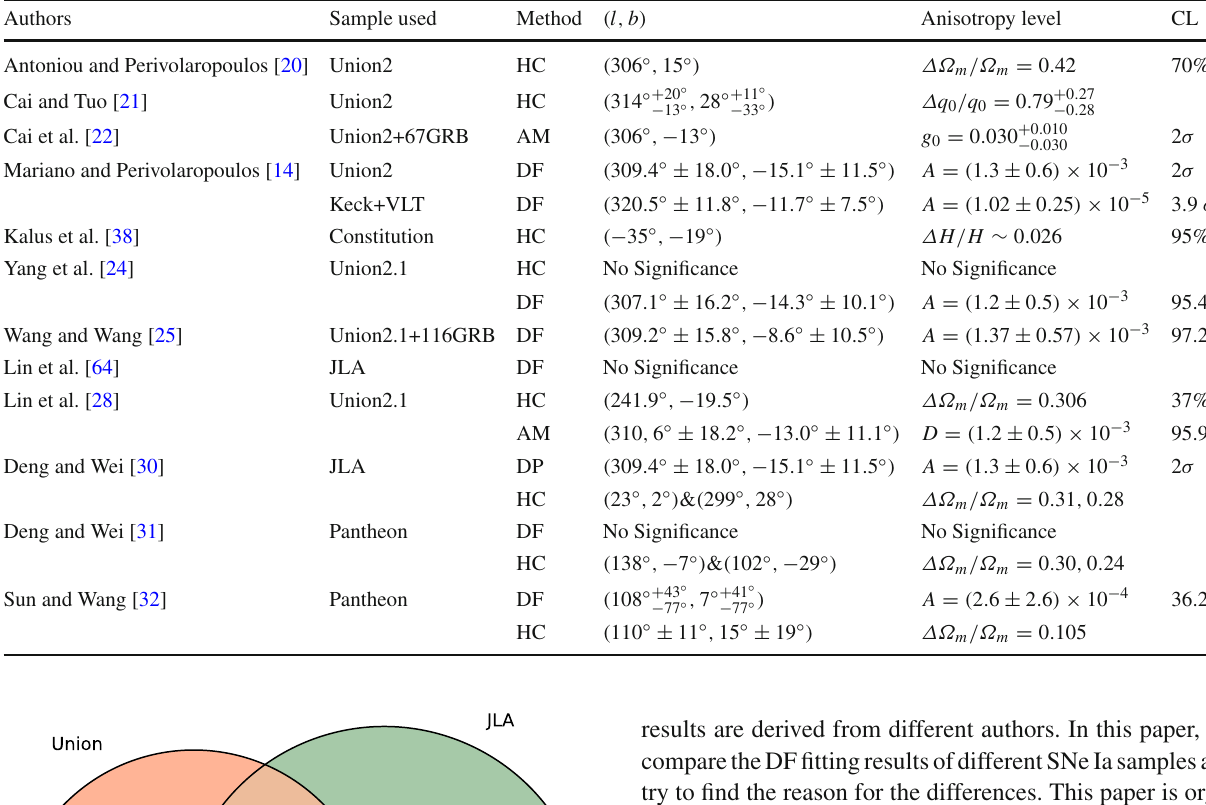
Table 1 Incomplete list of previous works on cosmological preferred directions. AM is short for a specific anisotropic model, DF for dipole fitting method, and HC for hemisphere comparison method Authors